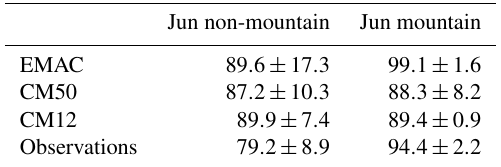
Table 5. The same as Table 4 but only for the stations located in the CM12